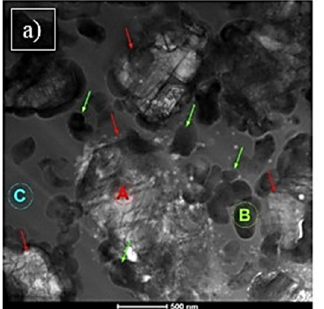
Figure 8. STEM micrograph in BF of sample C1 ( a ); the results of chemical analysis marked with letter A ( b ).